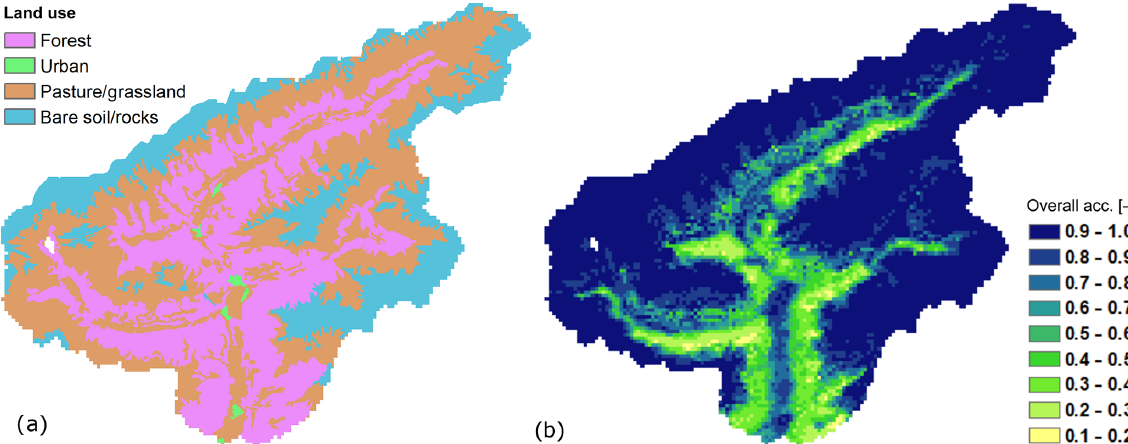
Figure 6. (a) Land use distribution for the catchment and (b) pixel-based overall accuracy (OA) of the comparison between simulated and MODIS-derived snow cover maps, computed from 1 January to 30 June 2011 for a total of 50 MODIS snow cover